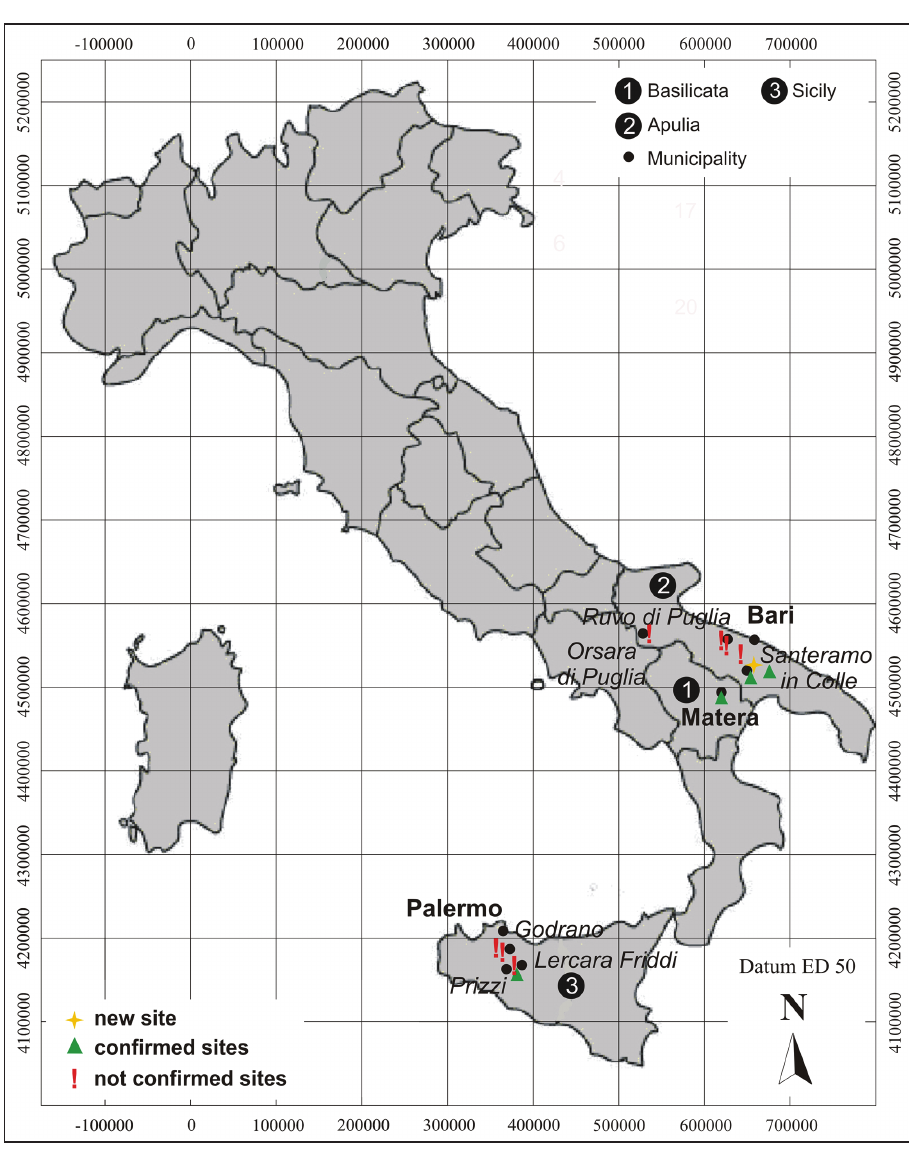
Figure 4. Geographic range and distribution map of Ionopsidium albiflorum in